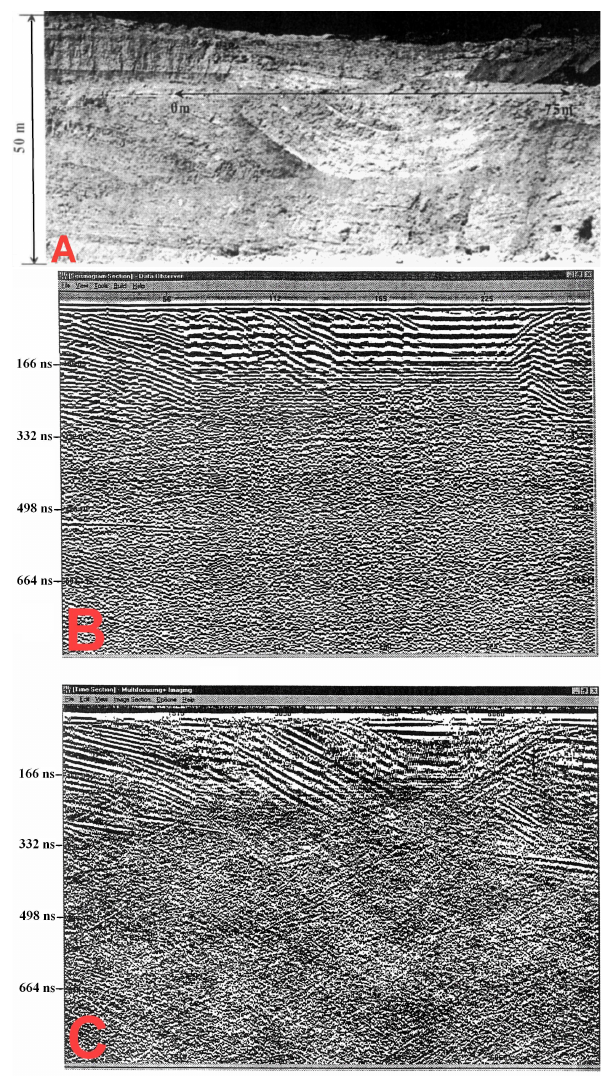
Fig. 7. ( A ) Photo of the geological section of a quarry “Nesher” (solid like in this section indicates location of the GRP profile). ( B ) Initial GPR section, ( C ) Multifocusing stack section (after Berkovitch et al.,